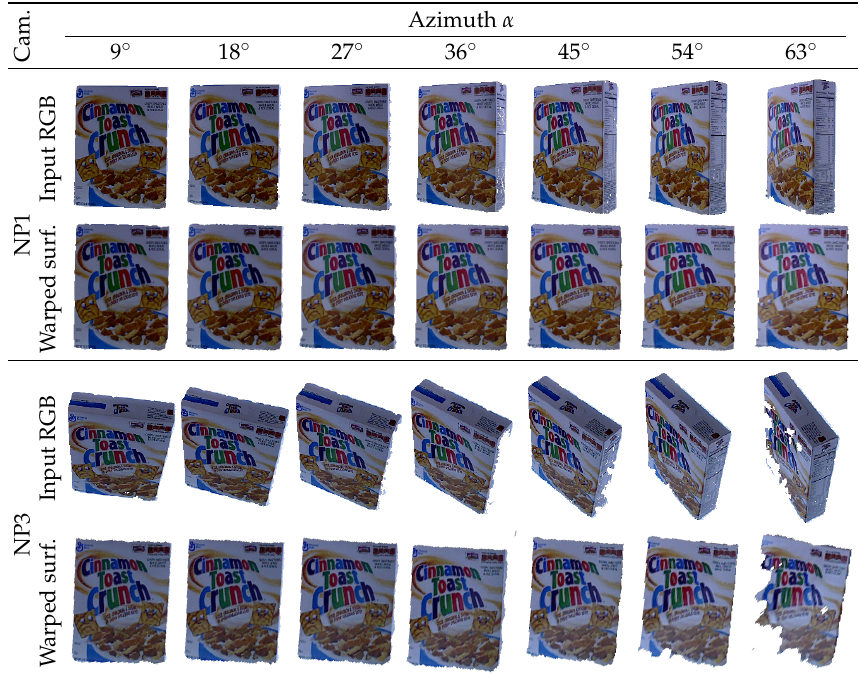
Figure 5. Warped smooth surfaces representing the frontal surface of a given sample. Despite various elevation and azimuth angles of the RGB-D input, smooth surfaces remain aligned to the virtual image plane. NP1 and NP3 are two cameras fixed at 88.4 ◦ and 38.1 ◦ elevation angles, respectively. Although depth maps are also warped, only RGB images of the frontal surface are shown